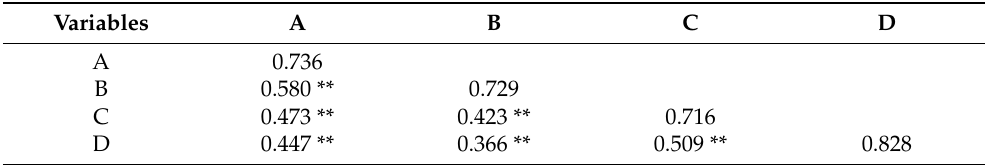
Table 4. Results of the discriminant validity test.